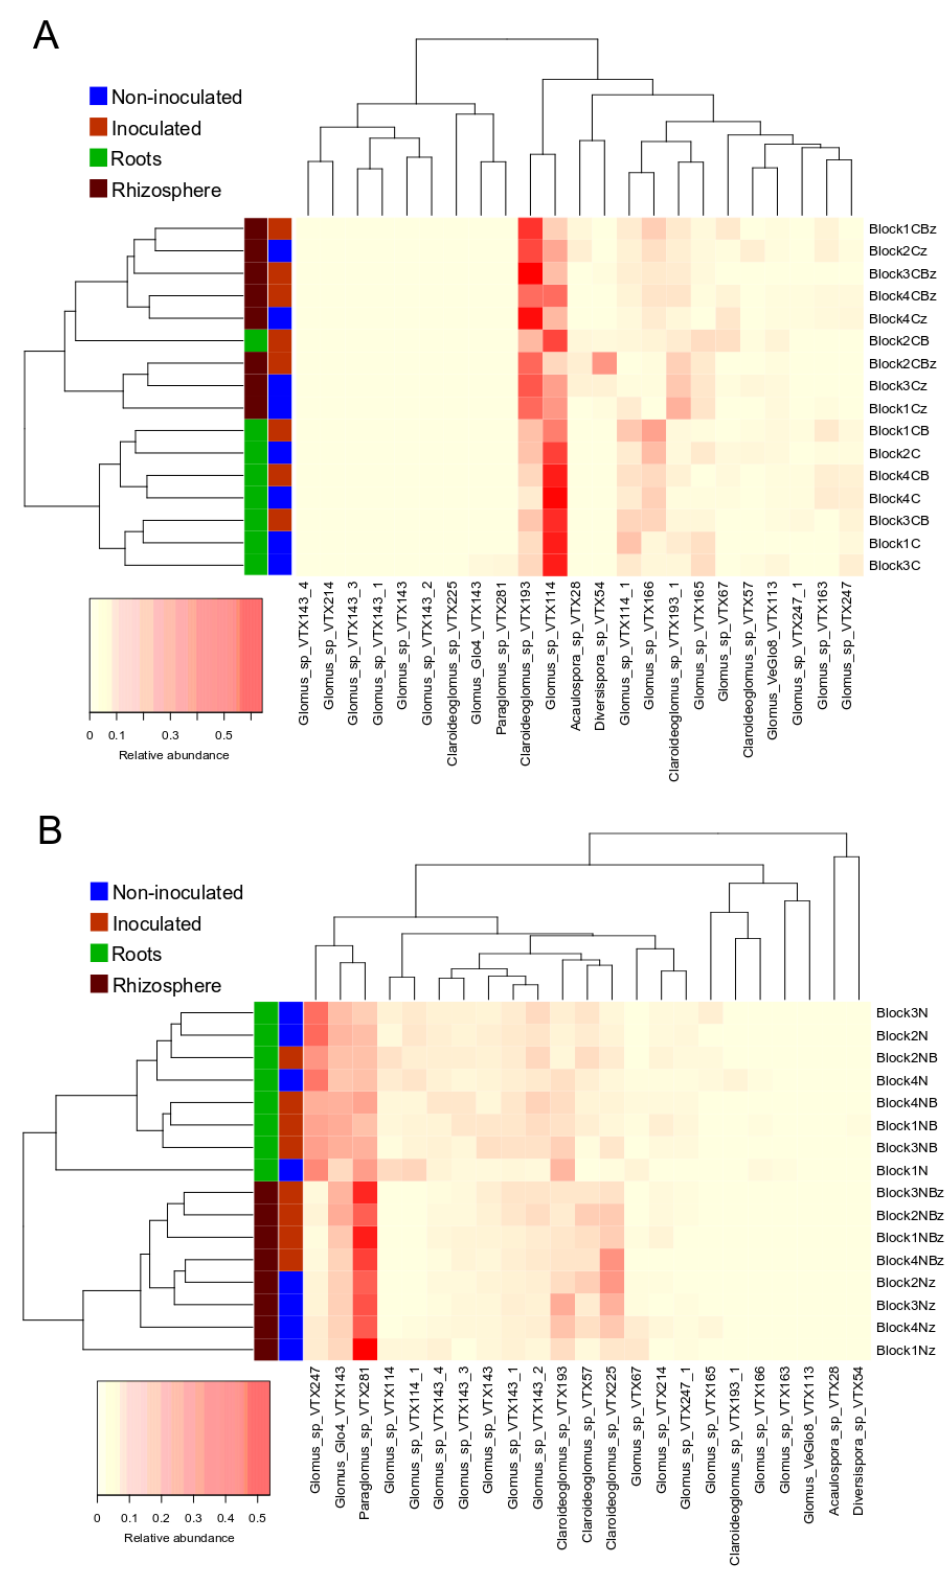
Figure 3. Heat map and UPGMA clustering based on the relative abundance of AMF OTUs in roots and rhizosphere in each block, from the different treatments in the contaminated soil ( A ) and the non-contaminated sediments ( B ). The colors of the last two squares on the left of rows represent the origin and treatment of each sample (biotope and inoculation).